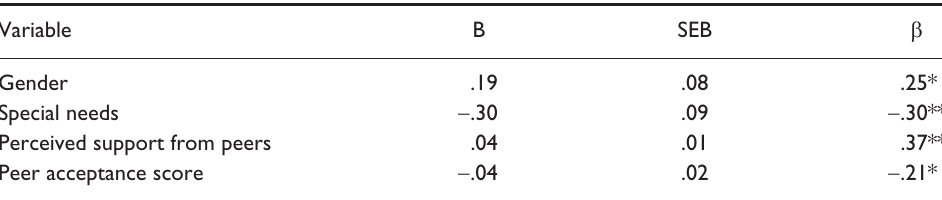
Table 5. Factors predicting friend stability